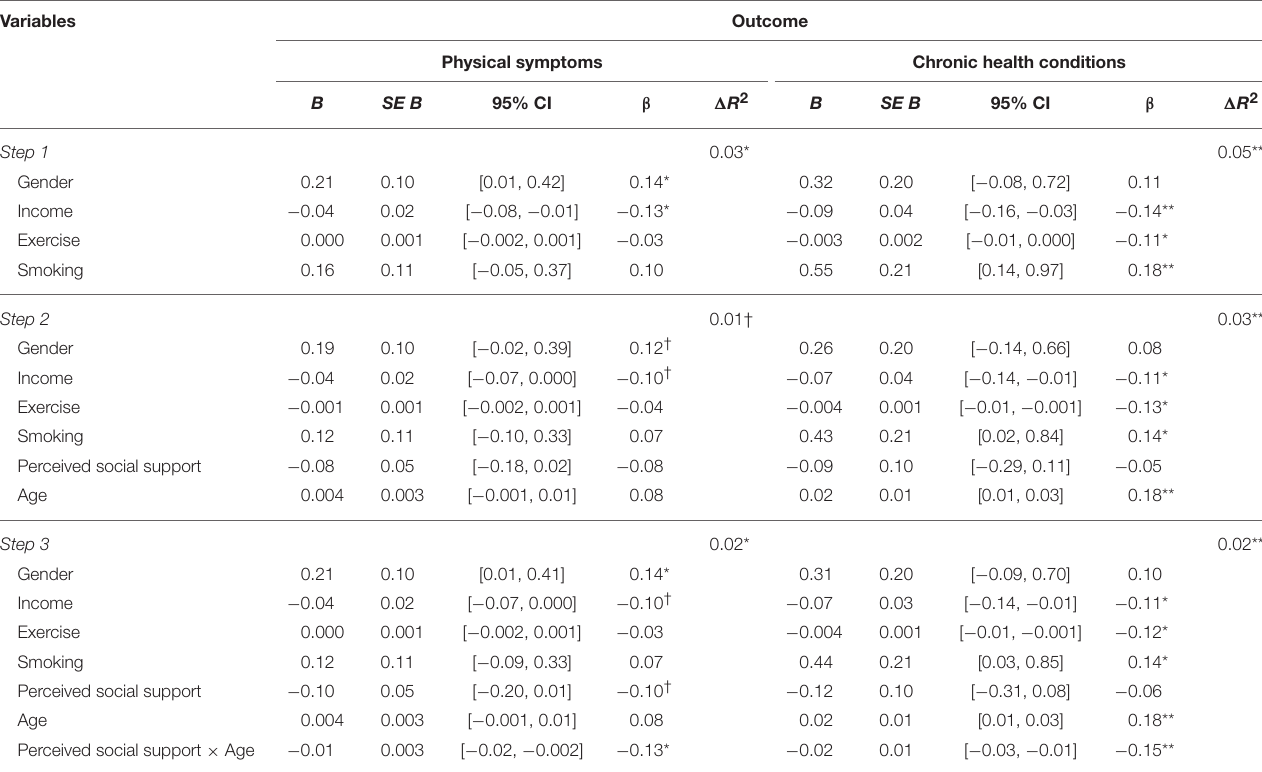
TABLE 3 | Summary of hierarchical regression analysis for variable predicting physical symptoms and chronic health conditions in Study 1. Variables Outcome Physical